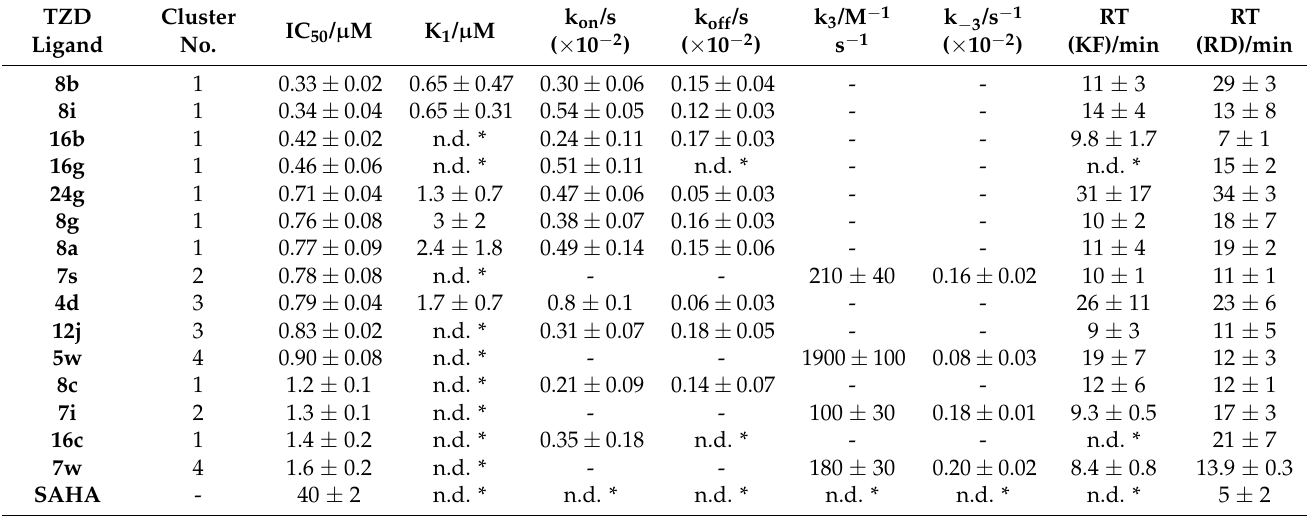
Equilibrium and rate constants refer to the reaction scheme in Figure 3. RD = rapid dilution, RT = residence time, KF = kinetic fit of one step (k − 3 − 1 ) and two step (k off − 1 ) model. Shown data represent means and standard deviations, N =